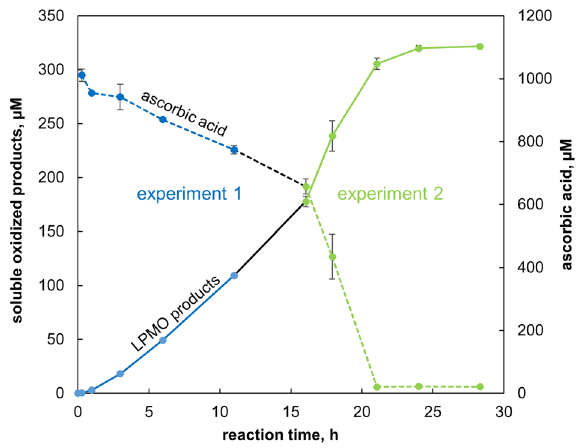
Figure 5. Release of oxidized products and reductant depletion in the reaction with 1 µM Sc LPMO10C + 2 µM Sc LPMO10C TR . The reactions were carried out at 30 °C in 50 mM sodium phosphate buffer, pH 6.0, supplied with 1% (w/v) Avicel and were initiated by adding 1 mM ascorbic acid. The data shown in blue and green color represent two independent experiments. The blue progress curves (“experiment 1”) are the same as shown in Figs. 3 and 4B. In the second identical experiment (green) only later time points were monitored. The black lines connect the blue curves with the green curves. The reductant concentration was determined by UV spectroscopy immediately after removing the insoluble LPMO substrate by filtration. Error bars indicate standard deviations for